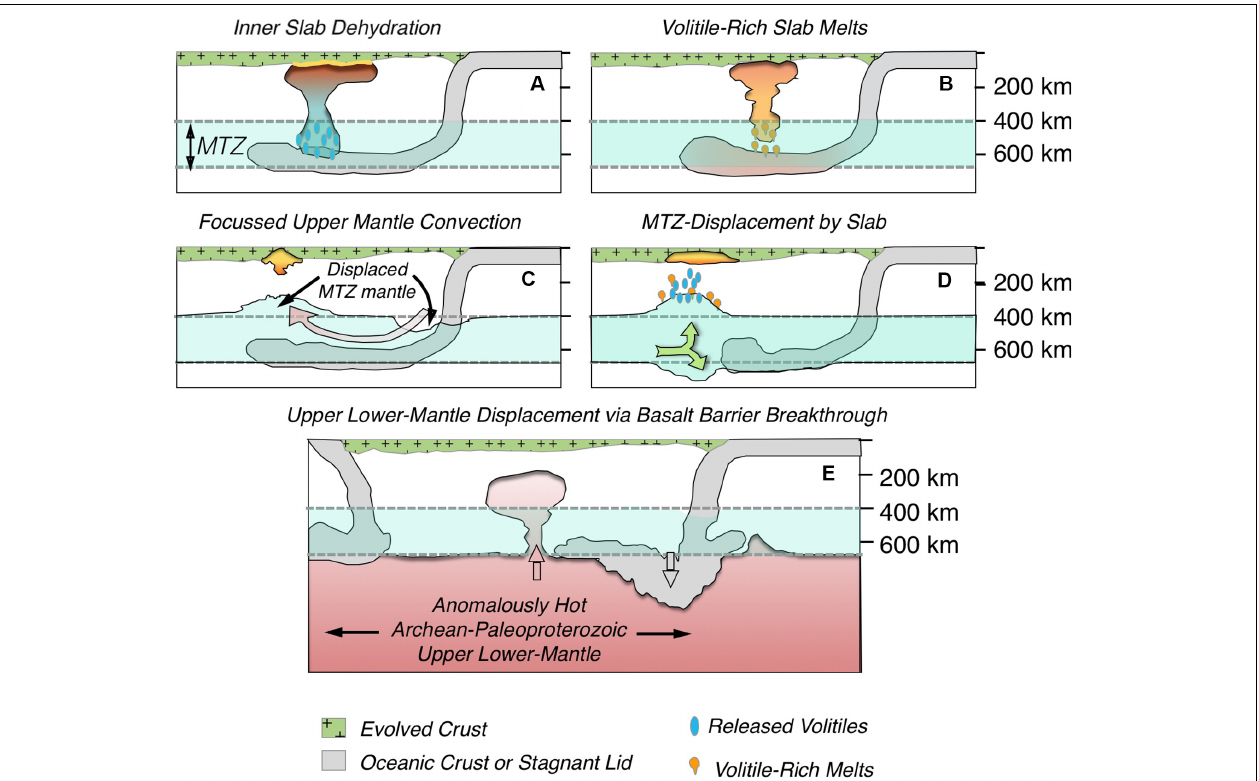
FIGURE 2 | Simplified illustrations of Phanerozoic Big Wedge processes proposed by various studies. (A) Dehydration of the inner slab leading to formation of a wet buoyant mantle upwelling (e.g., Yang et al., 2018). (B) Generation of volatile-rich melts from the slab, which metasomatize parts of the wedge causing melting and ascent of the buoyant melt-zone (e.g., Li et al., 2017). (C) Focused mantle convection (pink arrow) inducing displacement of hot and wet material from the MTZ (e.g., Faccenna et al., 2010). (D) Upward displacement of the MTZ by slab movement and accumulation (e.g., Wang et al., 2016; Geng et al., 2019). If applied to the Archean, these models could include a ∼ 300 ◦ C thermal-step boundary layer near the base of MTZ, according to the basalt barrier theory. (E) Basalt barrier breakthrough: if such a barrier existed then it would have provided a thermal boundary near the base of the MTZ that was a potential site for shallow mantle plume generation. Additionally, as shown here, occasional boundary breakthrough by accumulated slabs would generate compensating upwellings from the hotter lower mantle (see Davies,